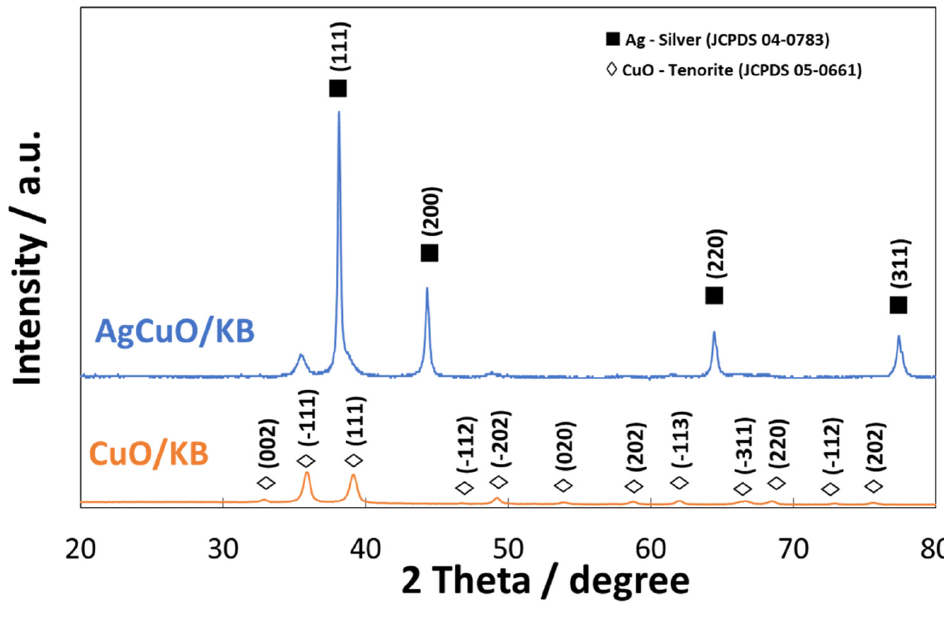
Figure 1. XRD pattern of the CuO-Ag/KB catalyst and CuO/KB catalyst.